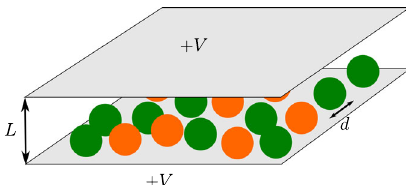
FIG. 1. Schematic drawing of the model porous electrode under consideration: Ions of diameter d are confined between two metallic surfaces separated by a distance L . A potential V (relative to the bath) is applied to the